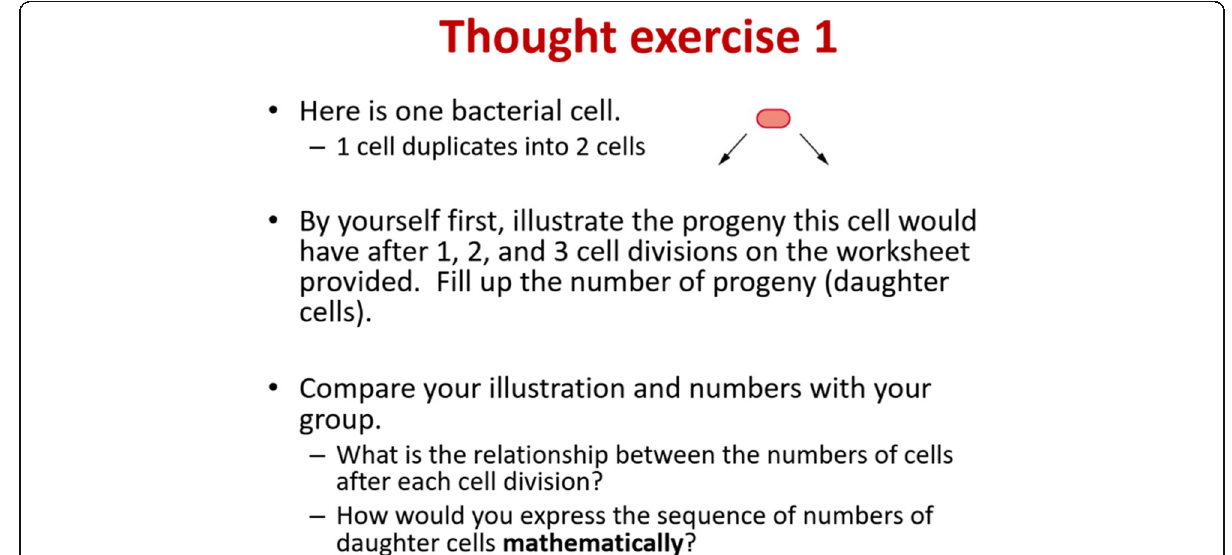
Fig. 2 Slide presented in Miguel ’ s instruction. Directions for building mathematical equation of the population growth of bacteria presented on a slide during